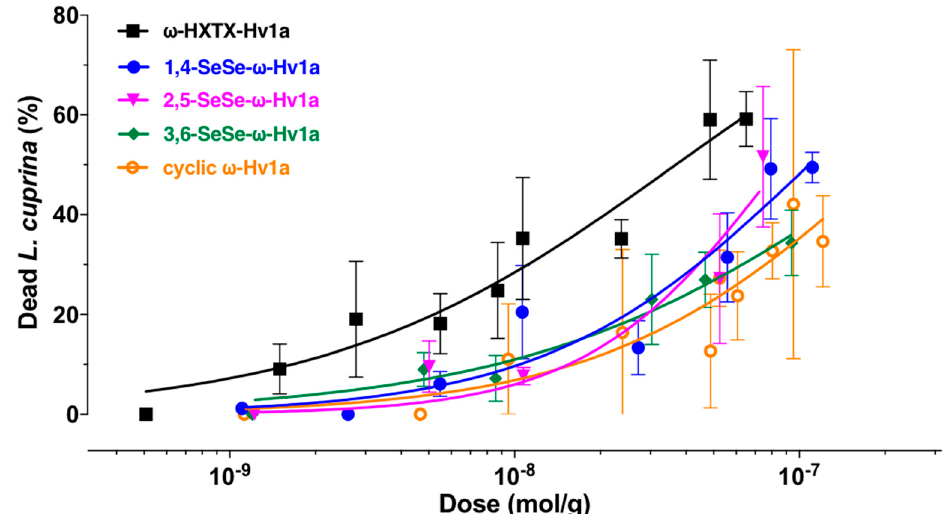
Figure 4. Oral toxicity assays. Lethality was determined 24 h after oral ingestion of toxin by sheep blowflies. All of the analogs have decreased oral activity compared to native Hv1a.